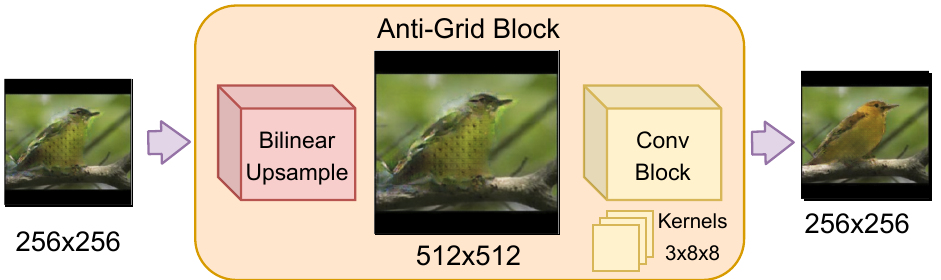
Figure 5. The Anti-Grid Block exploits a linear function to upsample the image, and 8 × 8 convolu- tional kernels provide the learned smoothing function.